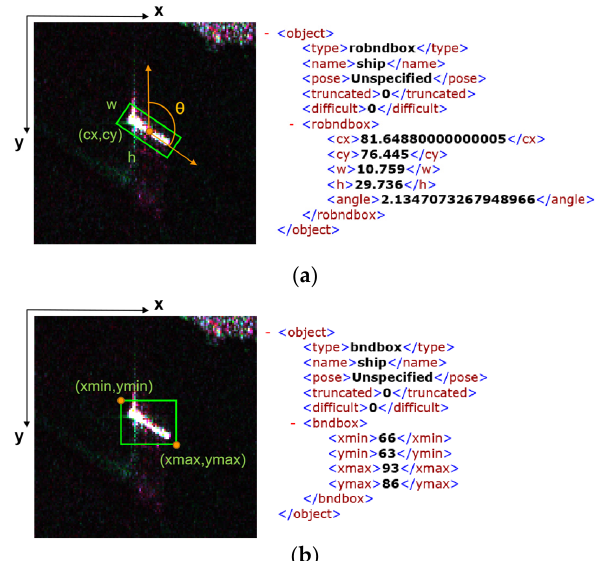
Figure 6. Ship slices are annotated as both RBoxes and BBoxes. ( a ) is detailed information of a RBox that represents a rotating rectangle; and ( b ) is detailed information of a BBox that represents a hor- izontal